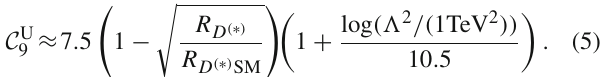
predicted values for these ratios. Right: Impact of favoured NP scenar- . Only central values for the NP scenarios are ios on the observable P (cid:4) 5 displayed. The most interesting scenarios cluster together while tradi- tional scenarios like C 9 μ = − C 10 μ or the scenario C 10 μ considered in Ref. [28] fail to explain this